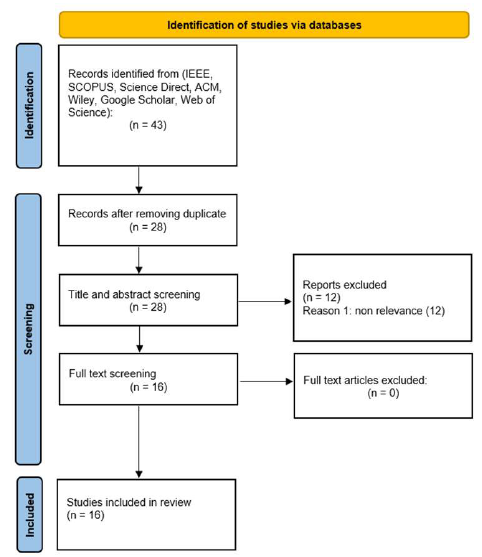
Figure 4. Identification of studies.